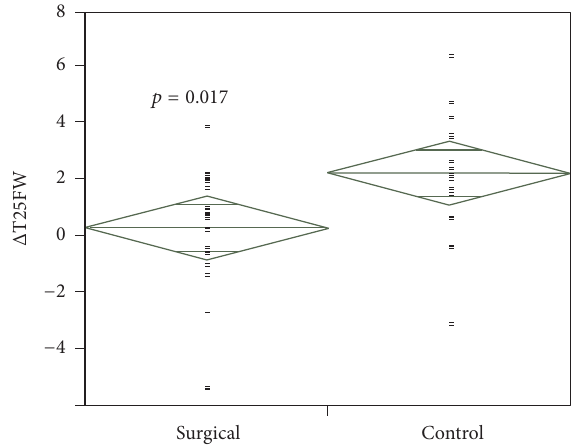
Figure 2: Distribution of (Post–Pre) T25FW differences between surgical and control